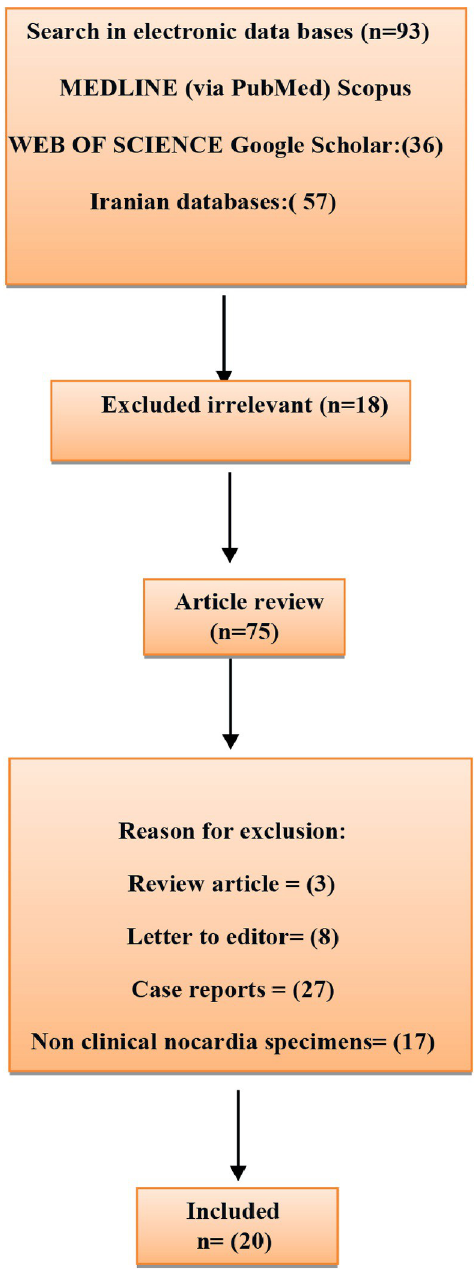
Fig 1. Flow diagram of literature